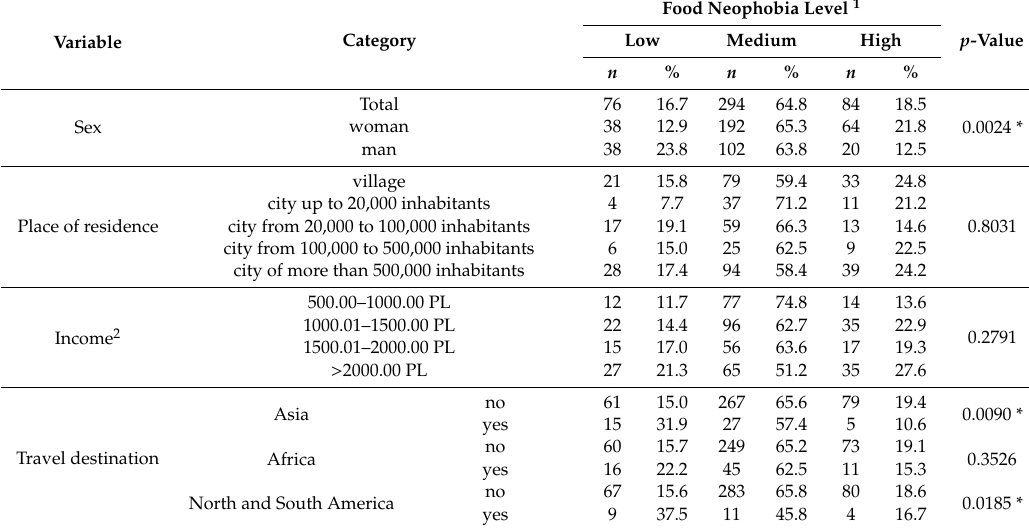
Table 2. The influence of selected variables on the food neophobia